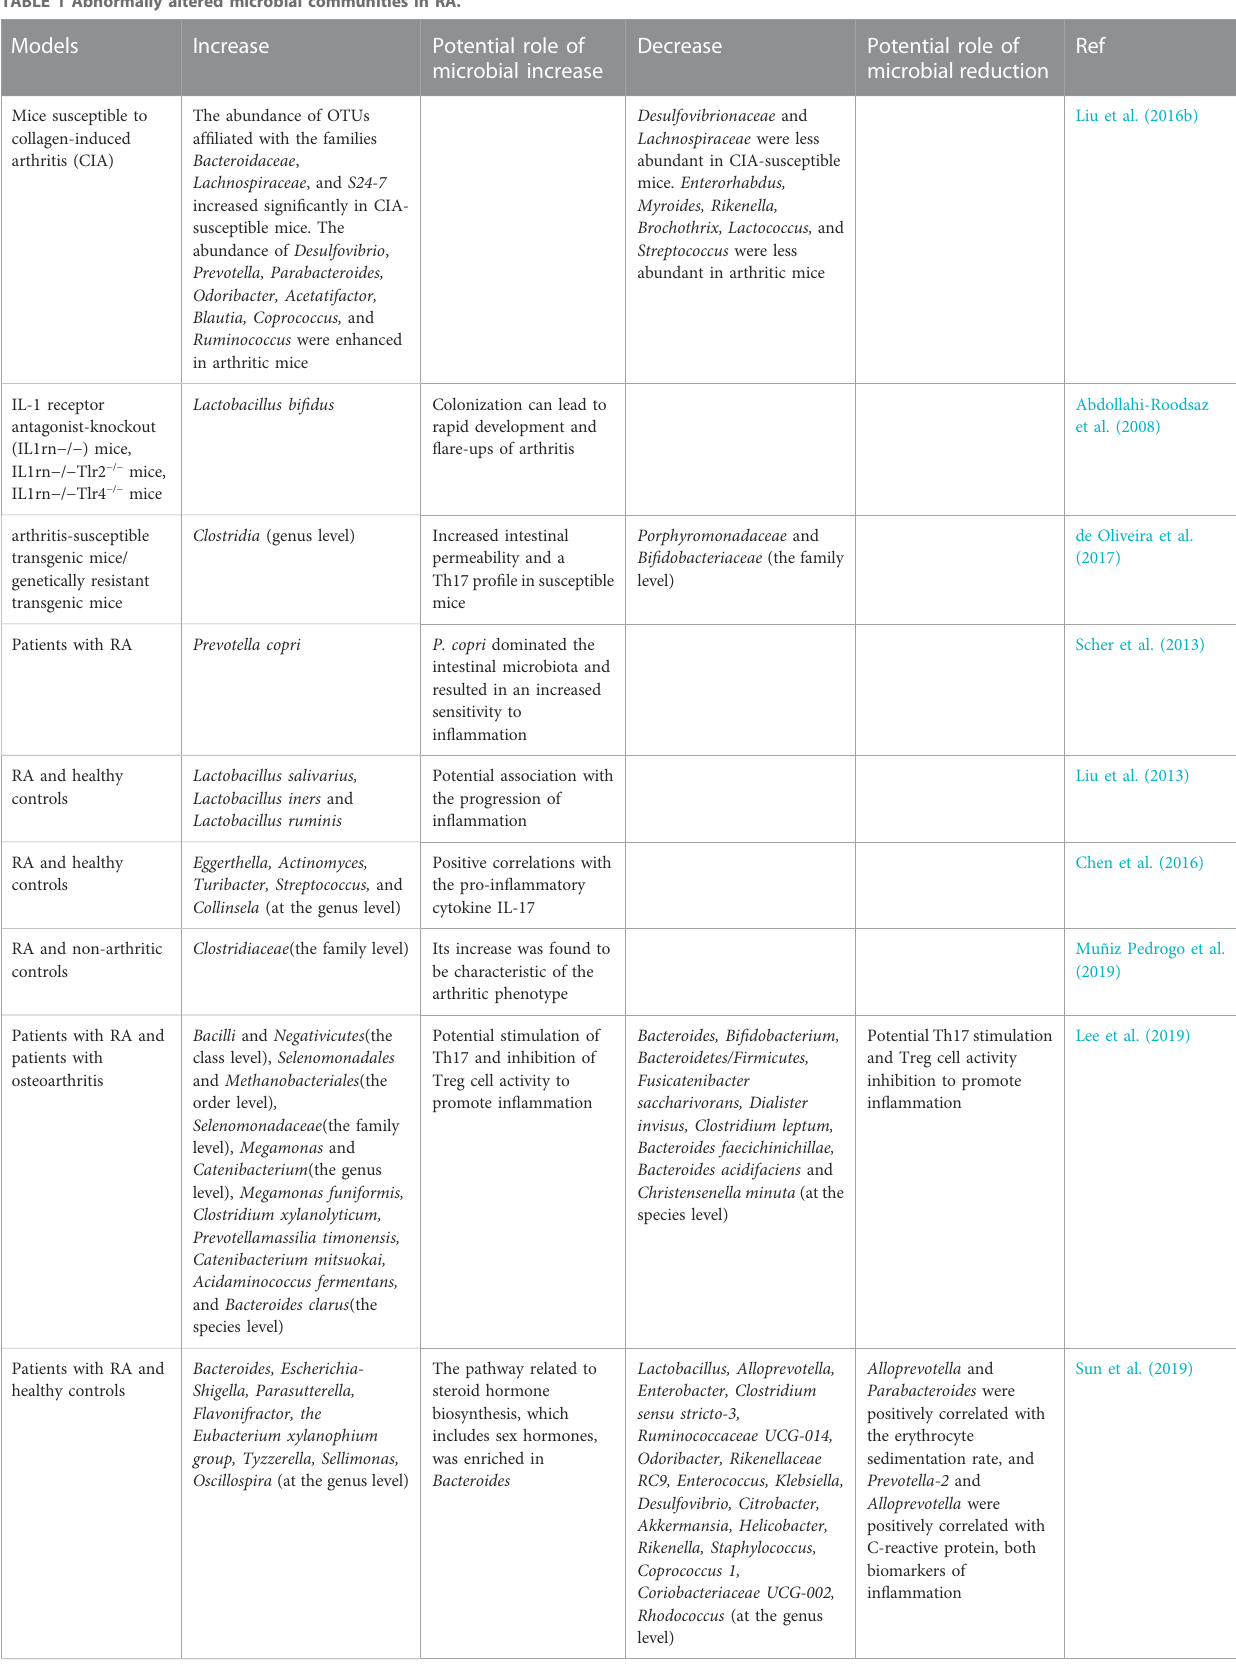
TABLE 1 Abnormally altered microbial communities in RA.